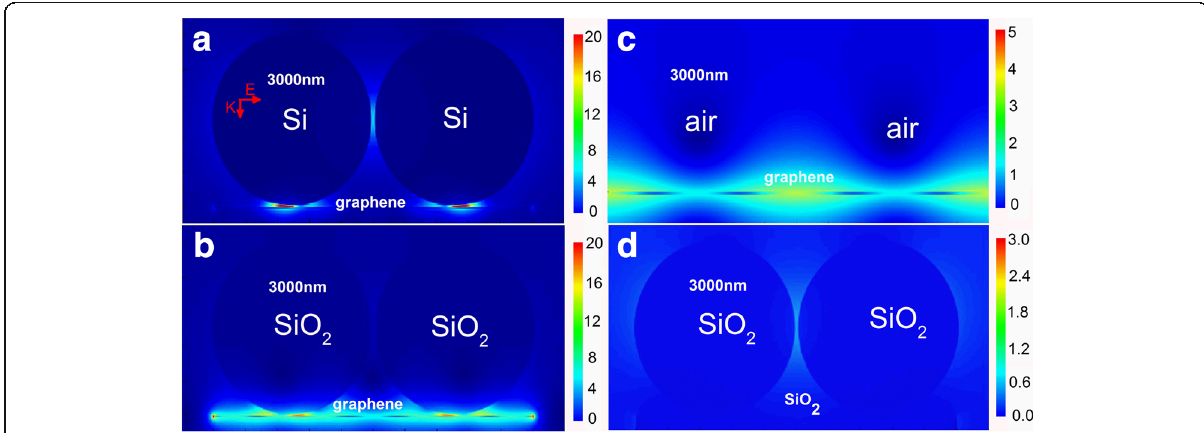
Fig 4 Electric field distributions in different dielectric nanoparticle/graphene hybrid system. a – c Electric field distributions of different permittivity nanoparticle dimers on monolayer graphene film with a 1-nm gap at 3000 nm. a Si ( n = 4.21 + 0.017i), b SiO 2 ( n = 1.5), c air ( n = 1). d Electric field distributions of SiO 2 nanoparticle dimer on SiO 2 film with a 1-nm gap at 3000